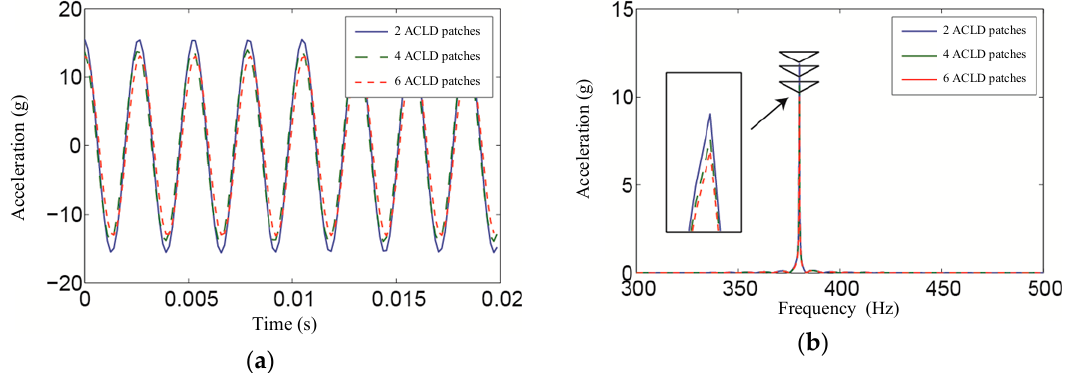
Figure 20. Vibration response in the ( a ) time domain and ( b ) frequency domain with a different number of ACLD patches.